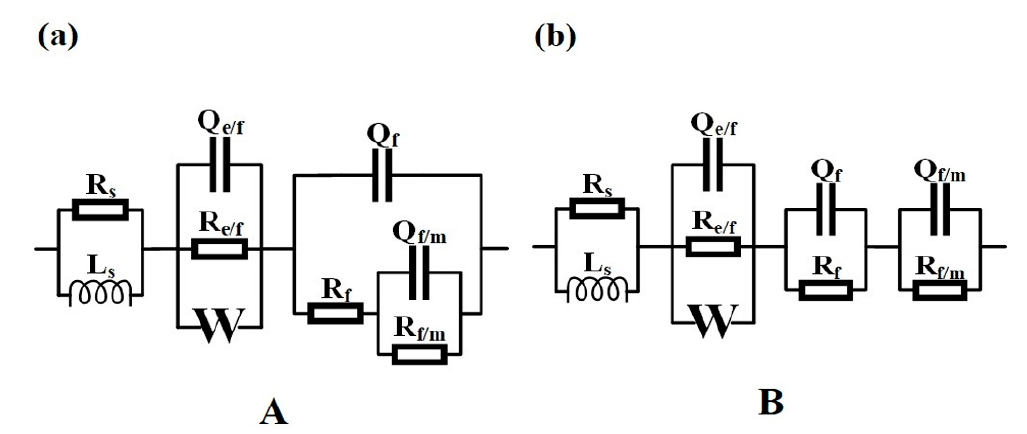
Figure 9. Equivalent electric circuits (EEC) for the Ni-Cr-Mo alloy coatings at OCP in 50 wt.% H 2 SO 4 solution at 60 °C: EEC A ( a ) and EEC B ( b ).